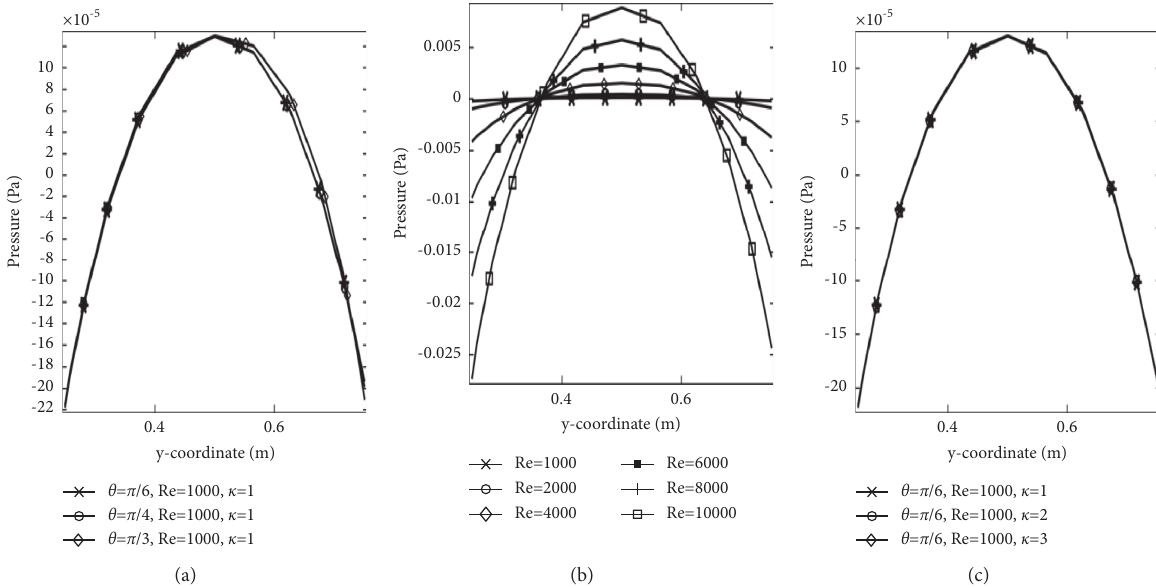
Figure 5: Pressure (Pa) description on the front surface of the circular cylinder (a) for all angles by fixing Re � 1000 and κ � 1; (b) for all Re by fixing κ � 1 and θ � π /6; (c) for all κ by Re � 1000 and θ � π